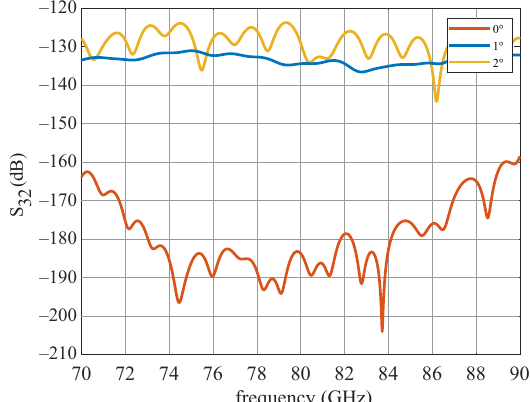
Figure 12. Simulated transmission S 32 for three